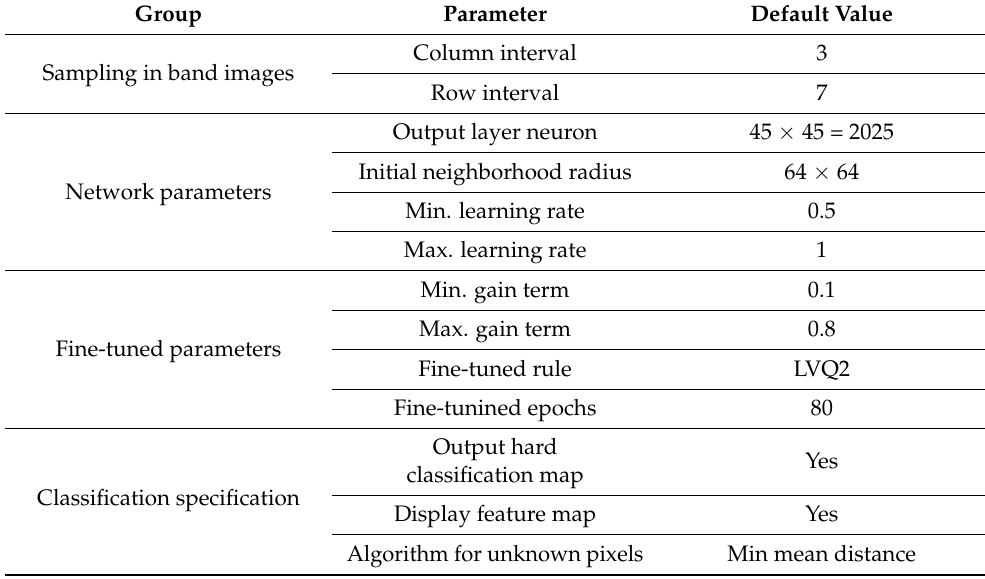
Table 1. Default characteristics and parameters of the ANN-SOM in IDRISI